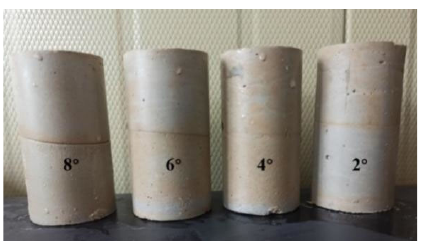
Figure 13. Preparation of dip Angle layered cemented backfill specimen.